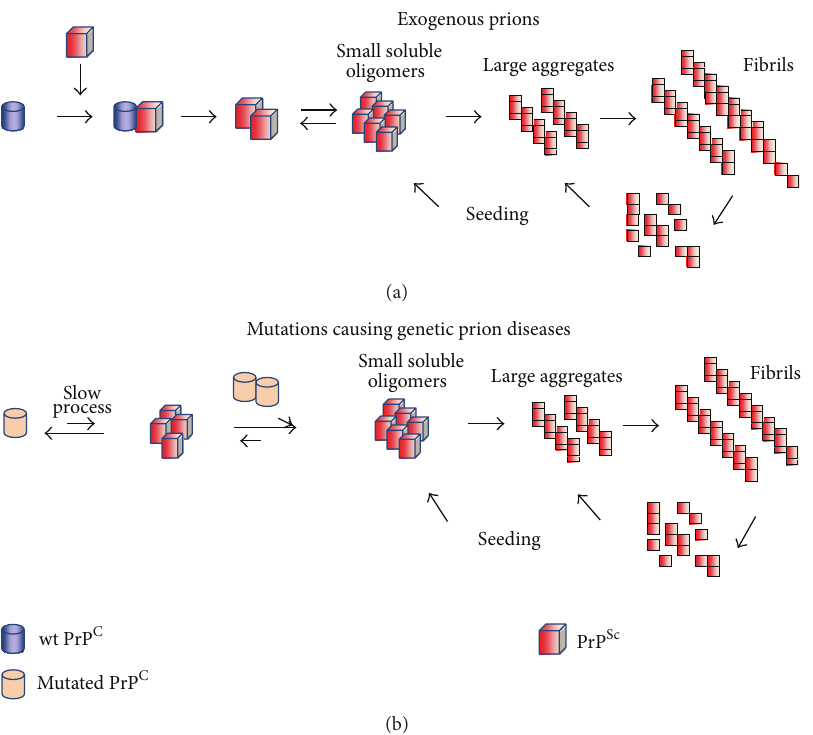
Figure 1: Proposed mechanisms of PrP C conversion into PrP Sc , with exogenous (a) or genetic (b) prions. Wild-type PrP C is represented by a cylinder colored in blue, mutated PrP C is outlined in blue, and PrP Sc is represented by red